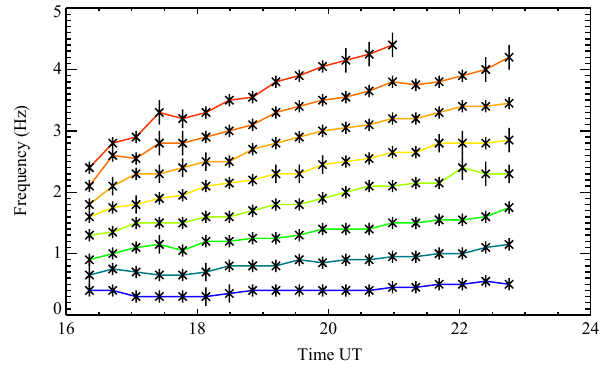
Figure 5. Spectral resonance features for 04/10/98 H component Fig. 5. Spectral resonance features on 4 October 1998 for the north polarization. The frequency variation over time for the first 8 harmonics was derived using method 1, using averaged spectra which represent 20 south (H component) polarisation magnetic field from Sodankyl¨a, minutes of data. The error bars give the uncertainty in frequency of the Finland. The frequency variation over time for the first 8 harmonics resonance peaks. was derived using averaged spectra, which represent 20min of data. The error bars give the uncertainty in frequency of the resonance